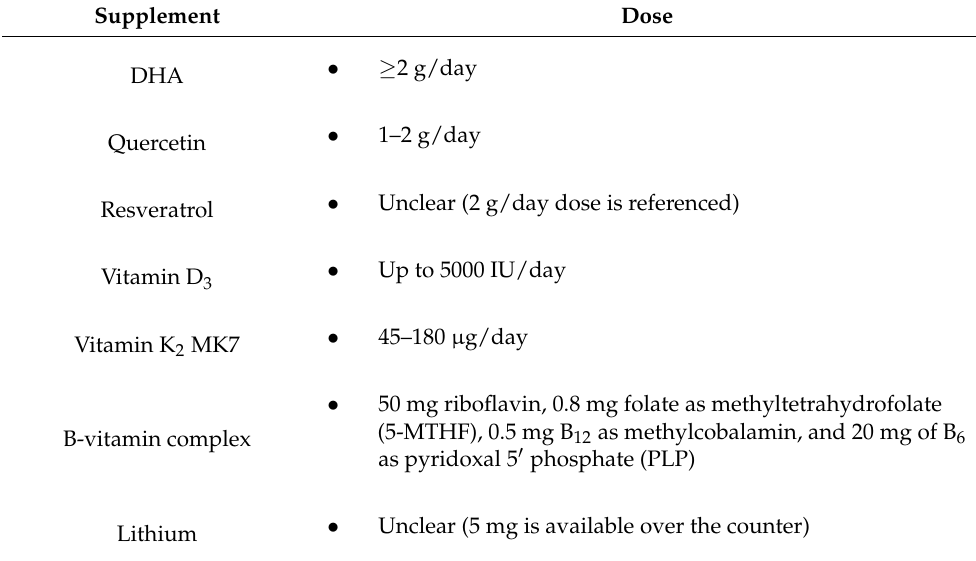
Table 2. Supplements and dosing